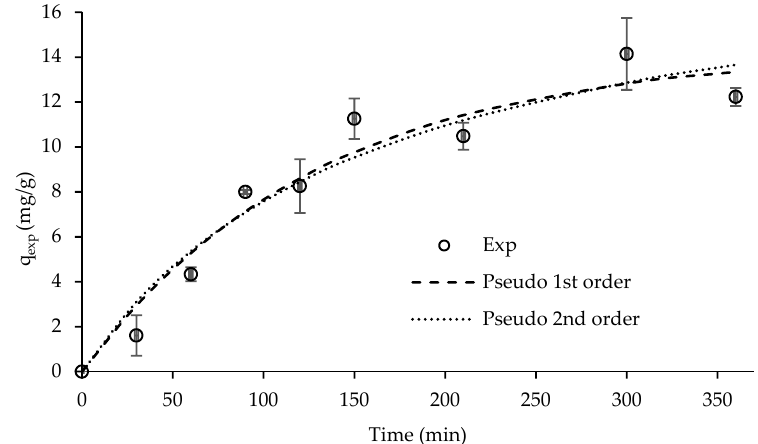
Figure 7. Kinetic data of RY removal by ST-derived char adjusted to pseudo-first and pseudo-second order kinetic models. Conditions: RY initial concentration = 100 mg / dm 3 ; solution pH = 6.0 (natural); char dosage = 4 g / dm 3 . Exp—experimental data. Error bars of duplicates are shown.